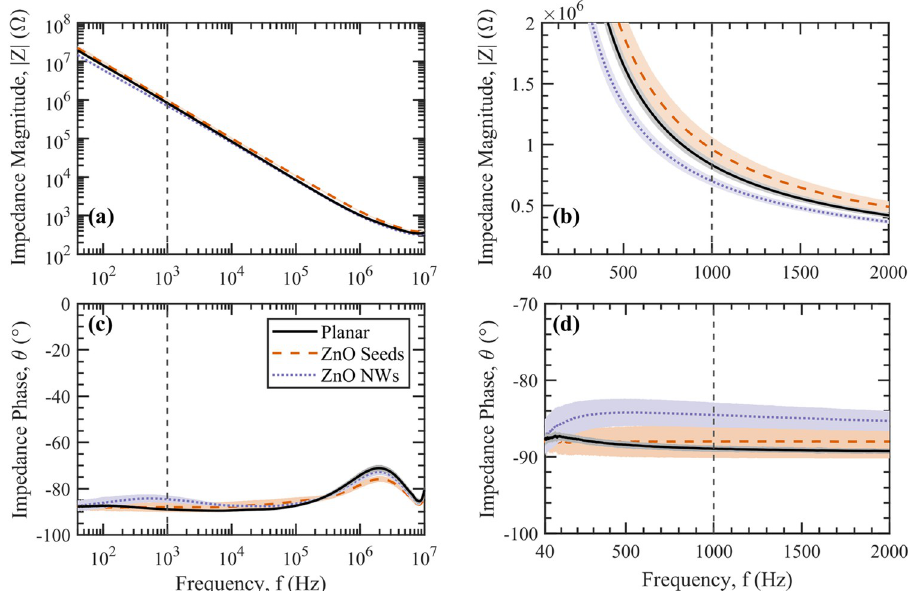
Fig 6. Electrochemical impedance spectroscopy (EIS) of planar microelectrodes, microelectrodes with ZnO seed layers and with pristine ZnO NWs. (a, b) Impedance magnitude and (c, d) impedance phase are plotted vs frequency with dashed lines indicating the frequency of 1 kHz. (b) and (d) show the electrochemical impedance magnitude and phase, respectively, for the frequency range of 40 Hz to 2 kHz in linear scale. Error shades represent one standard deviation (N � 20